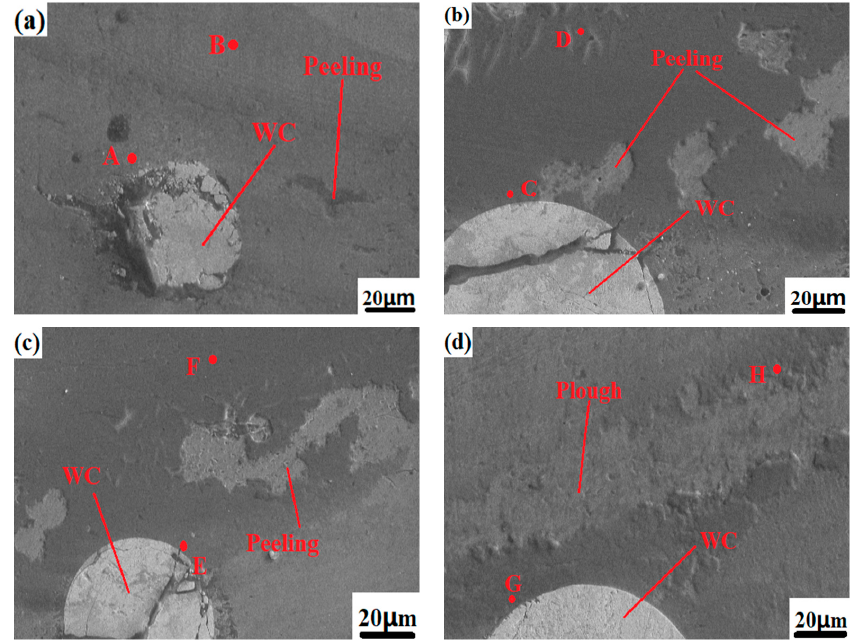
( d ) Figure 9. SEM images of surface wear of samples. ( a ) Co-Cr; ( b ) Co-Cr-10%WC; ( c ) Co-Cr-30%WC; ( d ) Co-Cr-40%WC.